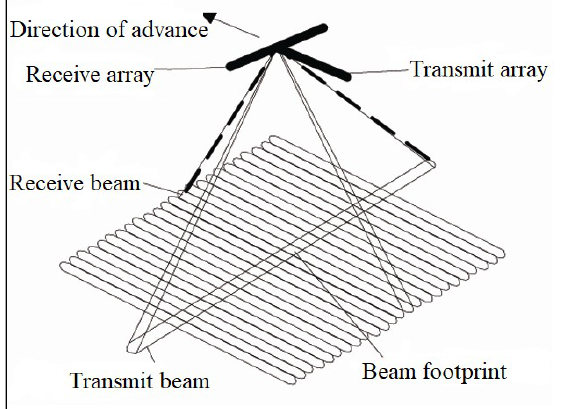
Figure 1. The multi-beam sounding system